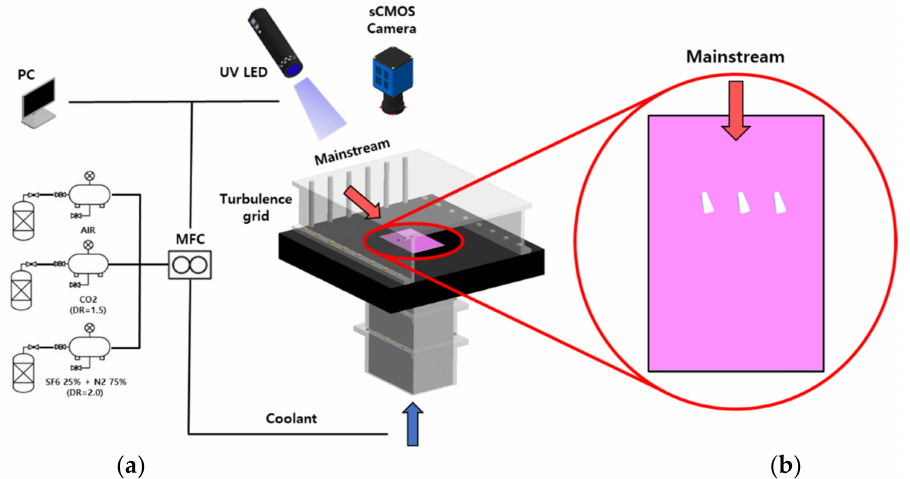
Figure 3. Schematic of the film cooling test apparatus: ( a ) test section; ( b ) test